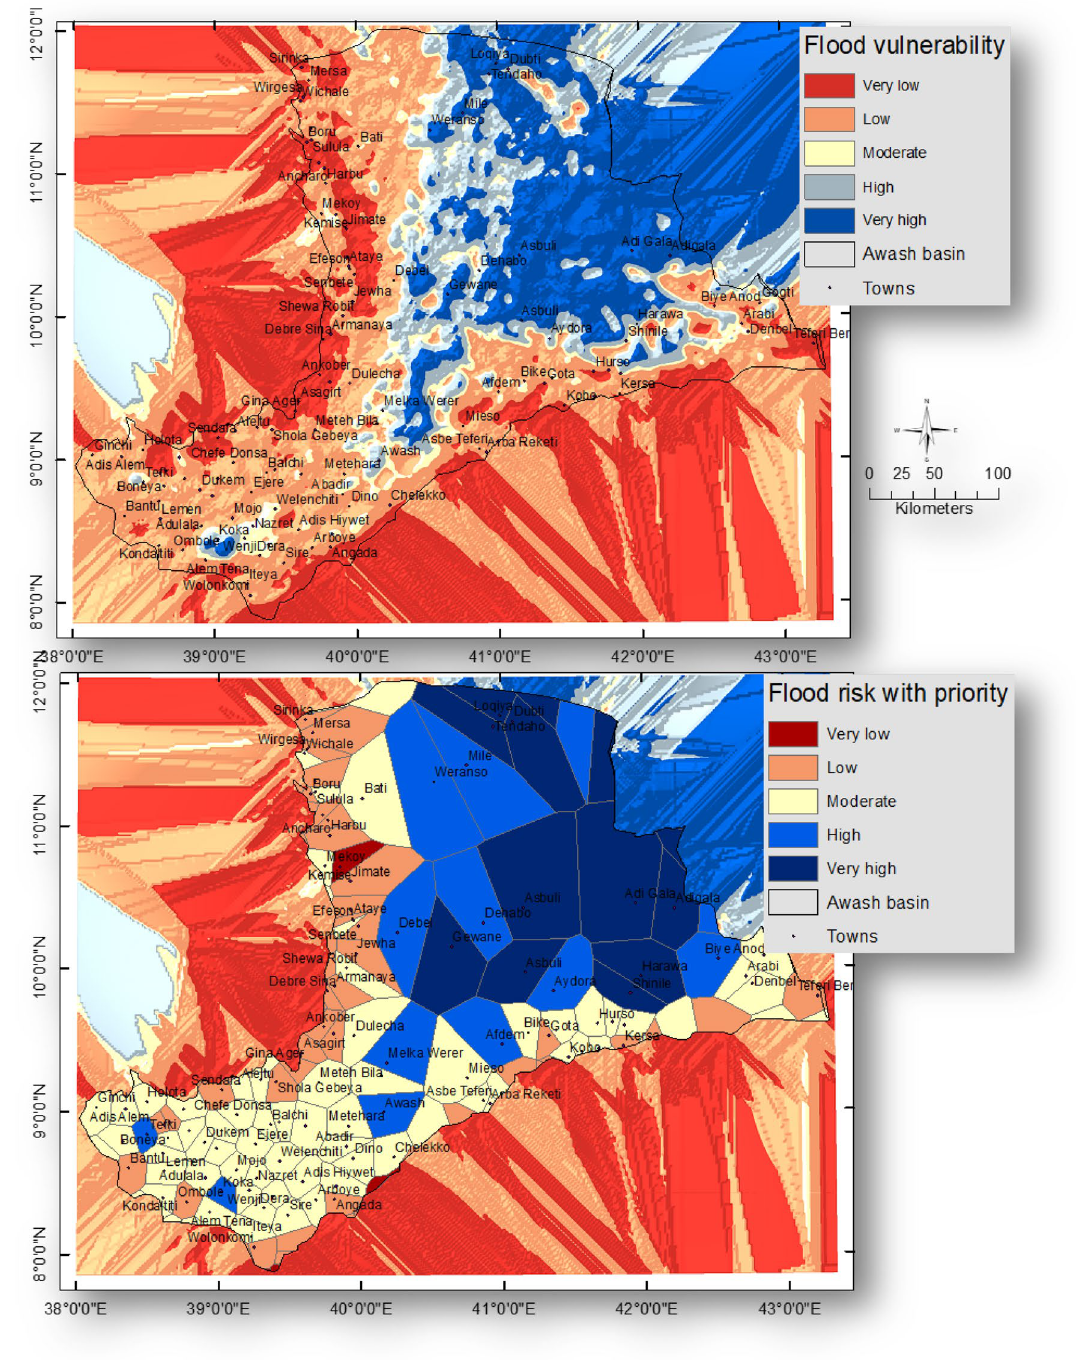
Figure 7. Spatial distribution of flood vulnerability and flood risk map of the Awash basin, Ethiopia. This figure was created using ArcGIS 10.3.1